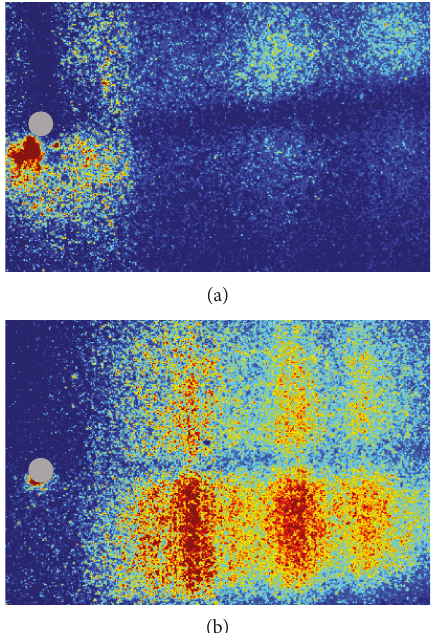
Figure 3: Wake fl ow fi elds depend on di ff erent jet directions. (a) The jet direction was at an angle of 45 ° to the surface of the fl at and (b) was 90 ° . The diameter=2 mm, Reynolds number =100, and sheet position =2 mm.